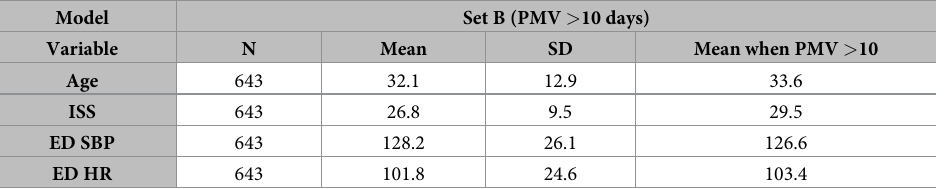
Table 3. Sample characteristics-continuous